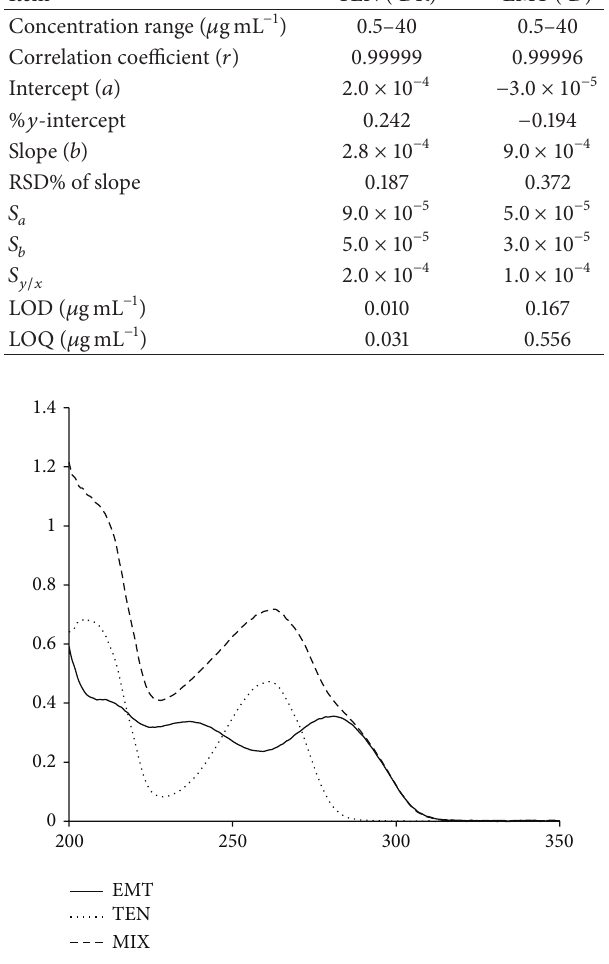
Figure 2: Absorption spectra of 1 𝜇 gmL −1 EMT, 1 𝜇 gmL −1 TEN, and their mixture in distilled